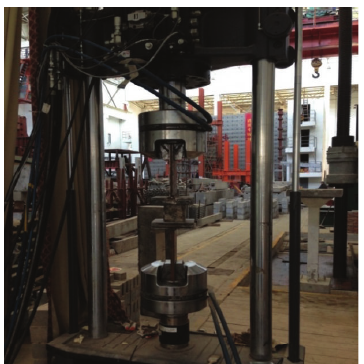
Figure 8: MTS 370.50 dynamic test system.